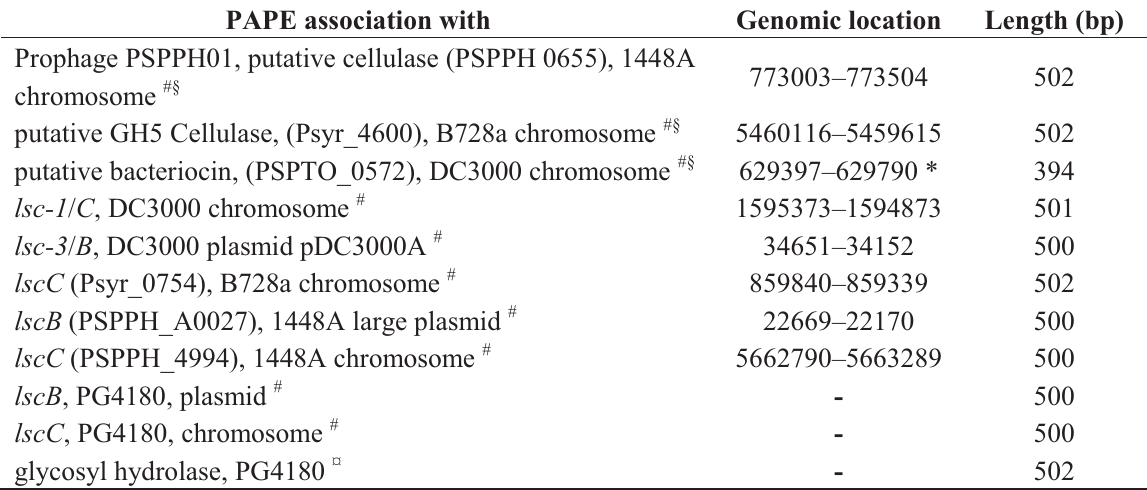
Table 2. Genomic location of PAPE associated with variant BC lsc